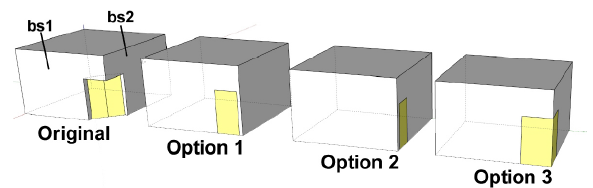
Figure 7. Impact of mapping the polygons to the boundary surfaces